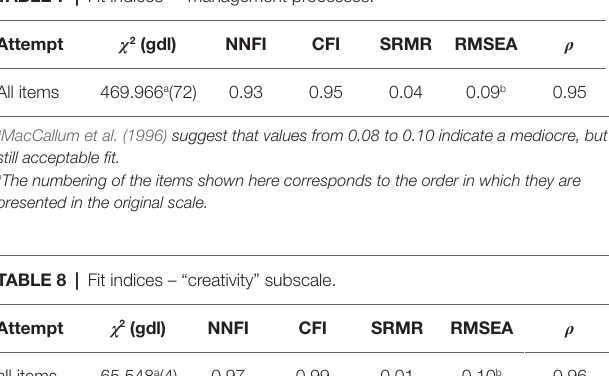
TABLE 7 | Fit indices – “management processes.”